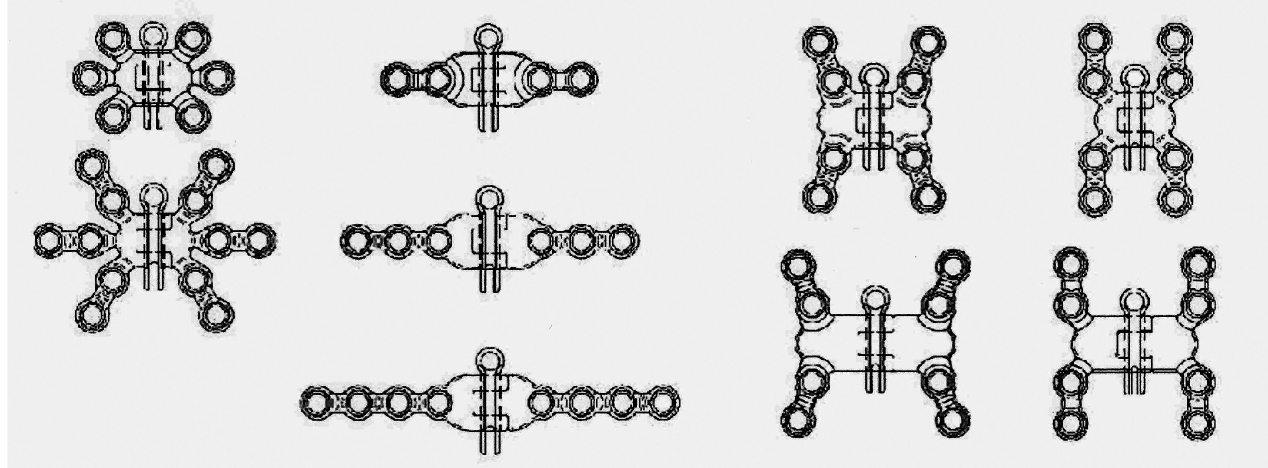
Fig. 1 - Models of plates with central pin - From right to left.: Star, straight, “X”,